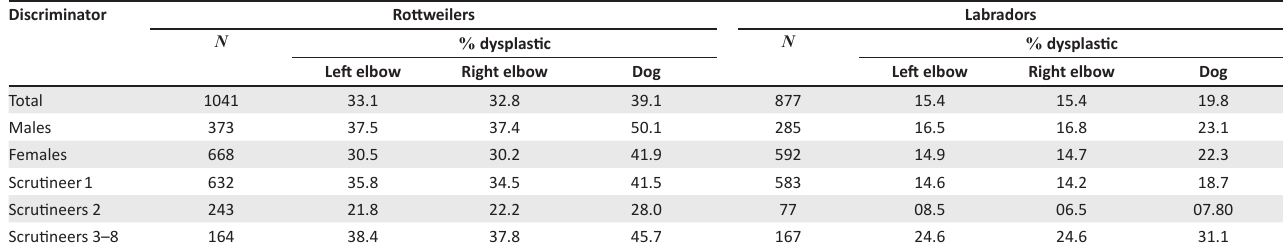
TABLE 2a: Prevalence of elbow dysplasia in Rottweilers and Labrador retrievers as well as in males versus females and primary versus secondary versus remaining scrutineers for left, right and both elbows (Grade 0, normal; Grades 1–3, dysplastic). Discriminator